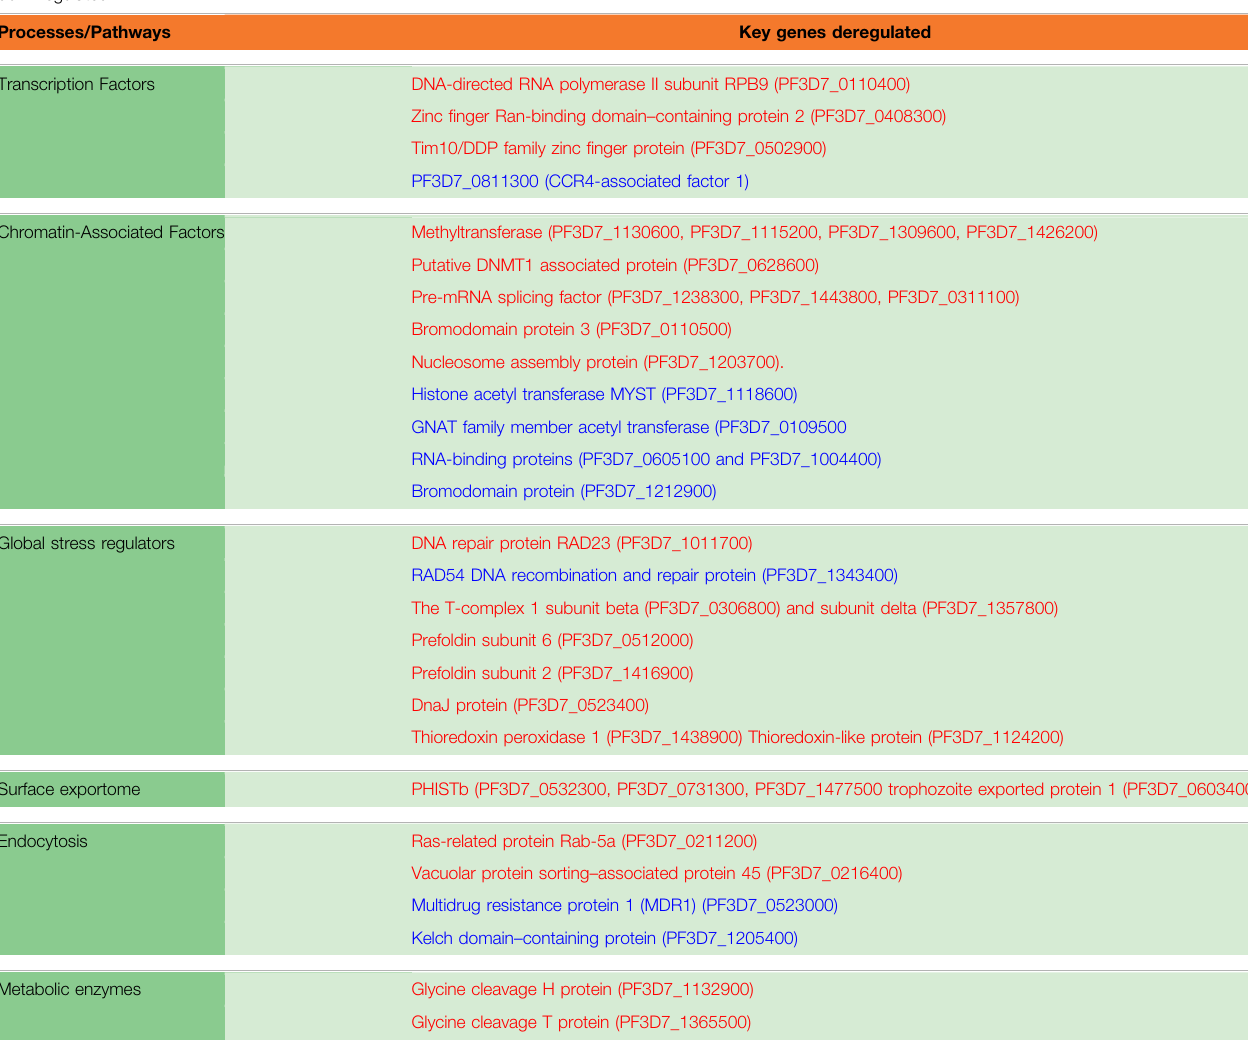
TABLE 2 | Pathways and gene implicated in artemisinin resistance. Genes in red are upregulated in resistant parasites, whereas those represented in blue are downregulated. Processes/Pathways Key genes